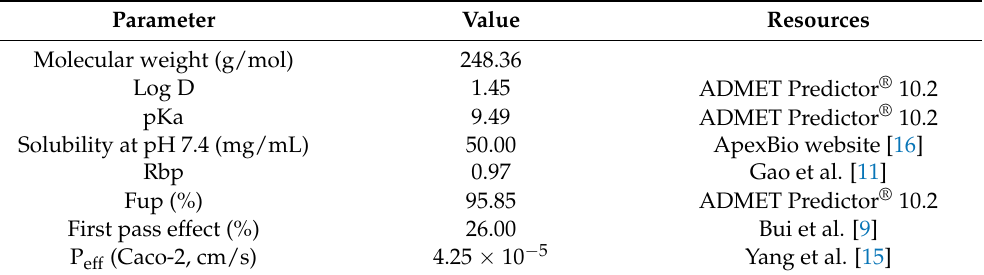
Table 3. List of final parameters of matrine that were used to implement the PBPK models. Parameter Value Resources Molecular weight (g/mol)